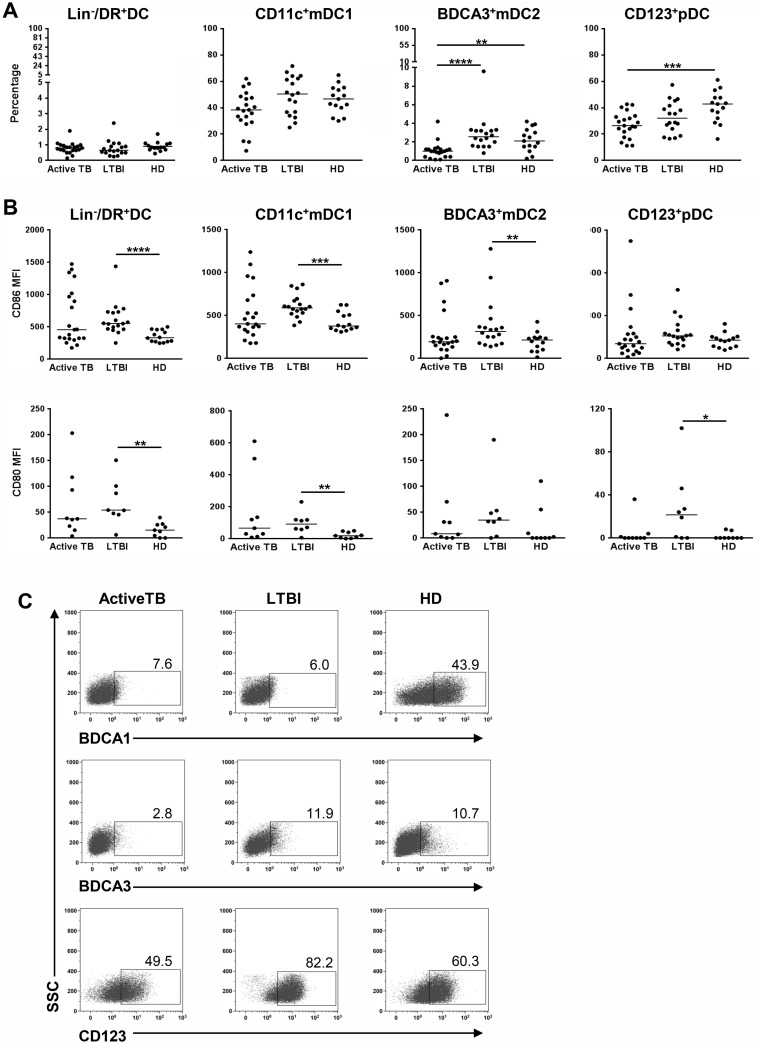
Analysis of circulating DC subsets in peripheral blood of active TB, LTBI or HD individuals.A, Percentage of peripheral blood Lin-/HLA-DR+ DCs, CD11c+ mDC1, BDCA3+ mDC2 and CD123+ pDCs were determined by flow cytometry. Median values are shown. B, CD86 and CD80 expression on total DCs and DC subsets are shown. Data are reported as mean fluorescence intensity (MFI) and median values are indicated. Statistical significance was analyzed by Mann-Whitney test using Bonferroni correction. *P<0.05; **P<0.01; ***P<0.001; ****P<0.0001. C, Expression of the type-1 and type-2 myeloid DC markers, BDCA1 and BDCA3, and the plasmacytoid marker CD123 in IFN-DCs derived from active TB, LTBI and HD individuals by flow cytometry. Active TB, LTBI and HD indicate IFN-DCs derived from active TB, LTBI and HD individuals, respectively. Percentages of positive cells are shown. SSC, side scatter. Data are representative of three independent experiments (N = 3).